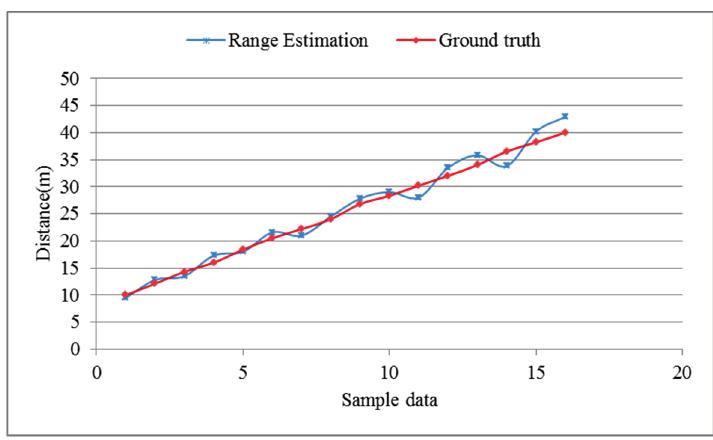
Figure 19. Range estimation results on the proving